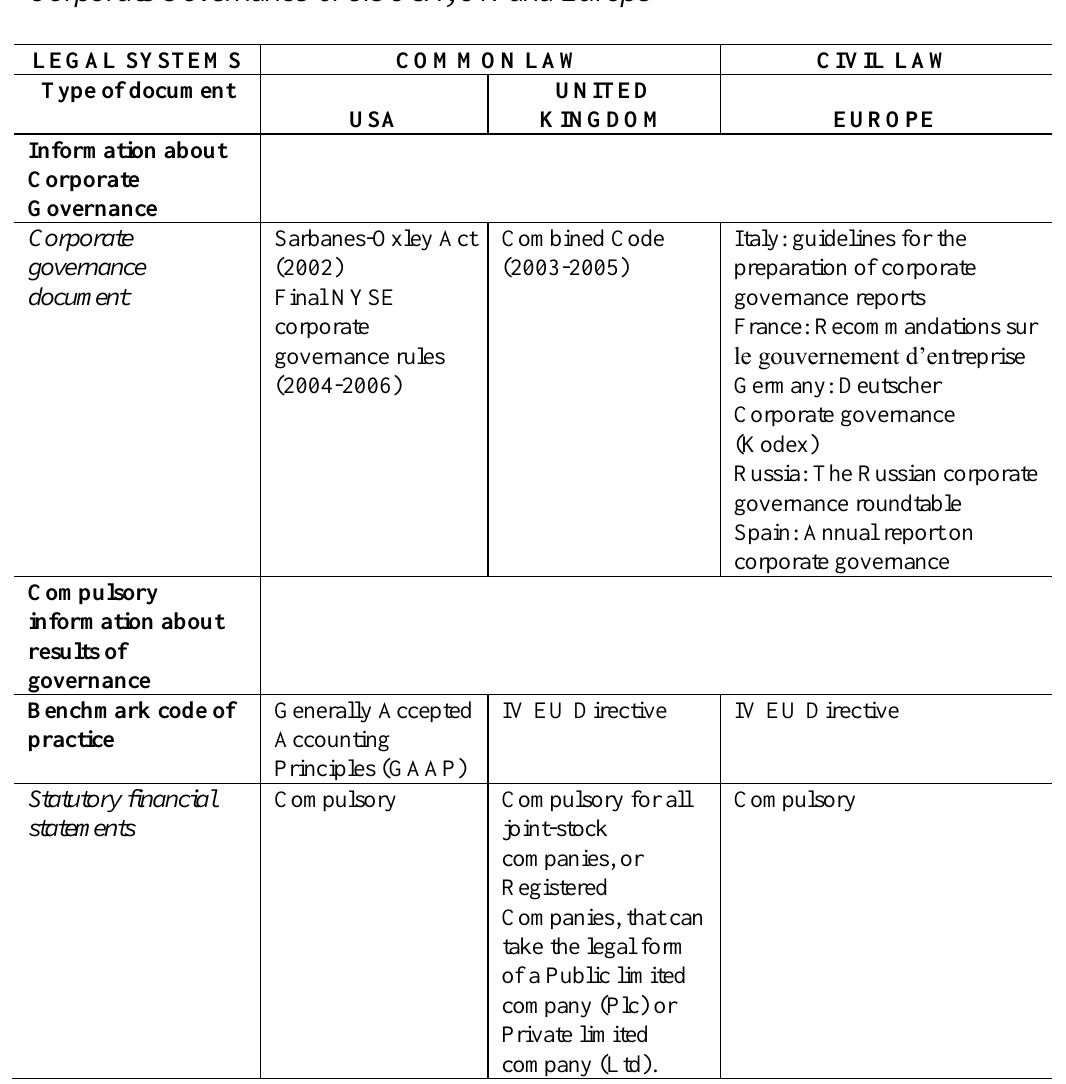
Table 4 : Comparative Analysis of Economic-Financial Communication and Corporate Governance in the USA, UK and